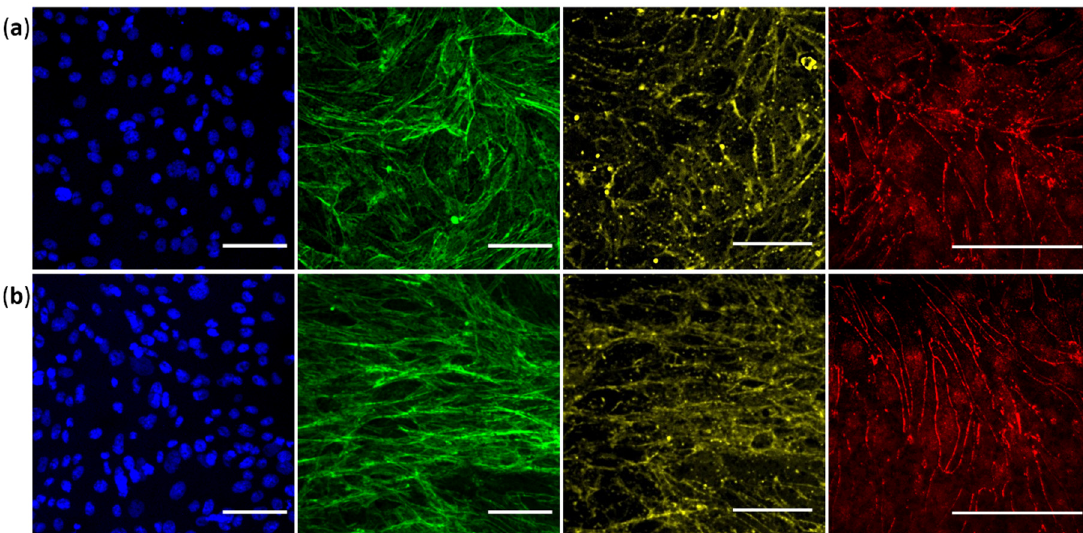
Figure 4. hCMEC/D3 cells cultured for seven days ( a ) in static condition or ( b ) including four days of shear stress exposure at 10 dyn·cm − 2 (flow direction is horizontal). Immunostaining was performed and observed directly in our home-made barrier device with a spinning disk confocal microscope. From the left to the right: nuclei in blue, F-actin in green, β - catenin adherent junction in yellow, and ZO-1 tight junction in red (providing from distinct experiment). Each image is representative of at least two independent experiments. Scale bars represent 50 µm.